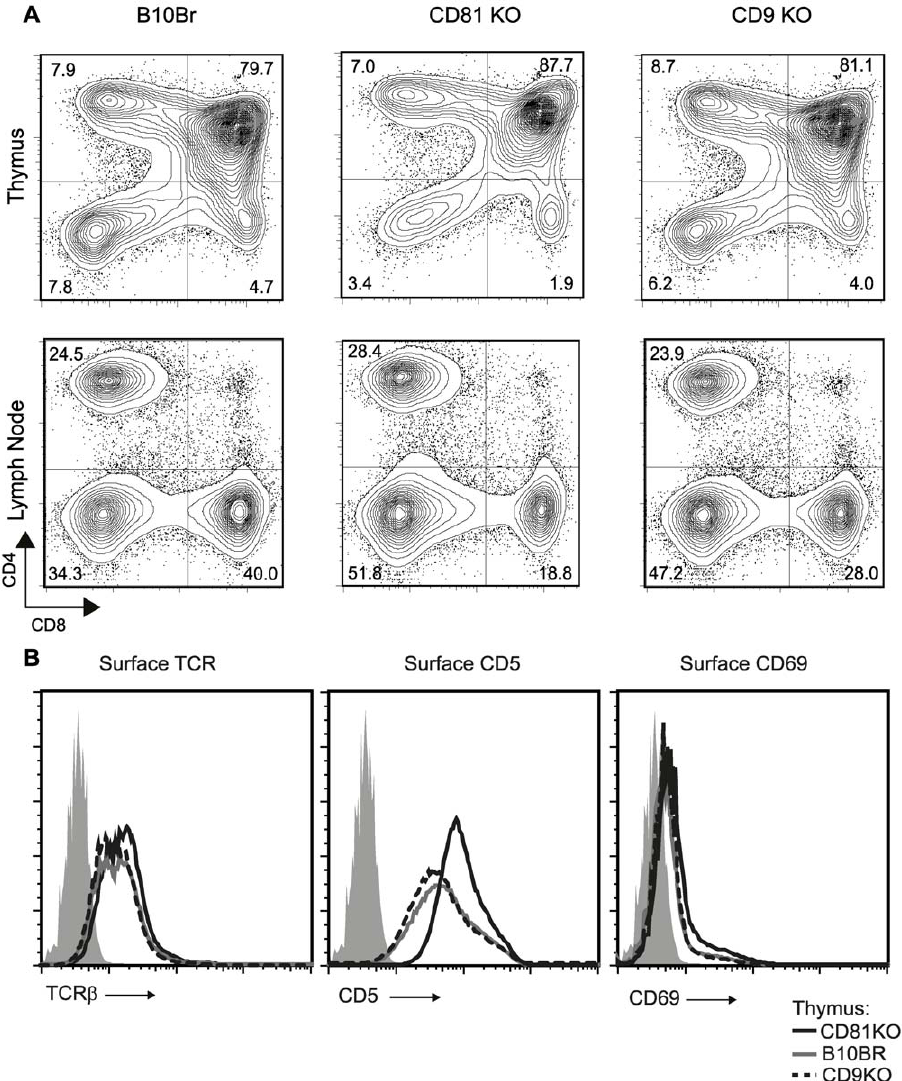
Figure 4. Inreased signaling intensity in CD81 2 / 2 thymocytes. ( a ) Deficiency of CD81 or CD9 does not affect T lymphocyte development and thymic cellularity. Thymocytes from B10, CD81 2 / 2 and CD9 2 / 2 mice were analyzed by multicolor flow cytometry. CD4 vs CD8 contour plots of thymocytes (top row) and lymph node cells (bottom row) are shown. ( b ) CD81 deficiency increases in vivo signaling intensity in DP thymocytes. Single parameter histograms of TCRß, CD5 and CD69 expression on electronically gated CD4 + CD8 + DP thymocytes from B10 (dashed line), CD81 2 / 2 (black line) and CD9 2 / 2 (grey line) are shown. The electronic gate used is depicted as a box in the top panels in (a).